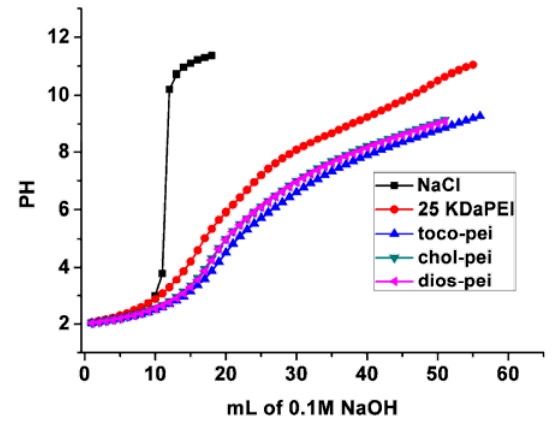
Figure 1. Acid–base titration profiles. Table 2. Buffering capacity.